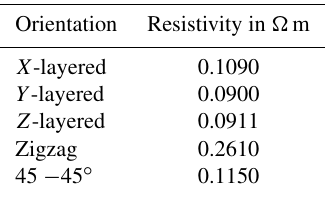
Table 2. Resistivity for different printing orientations and infill pat-